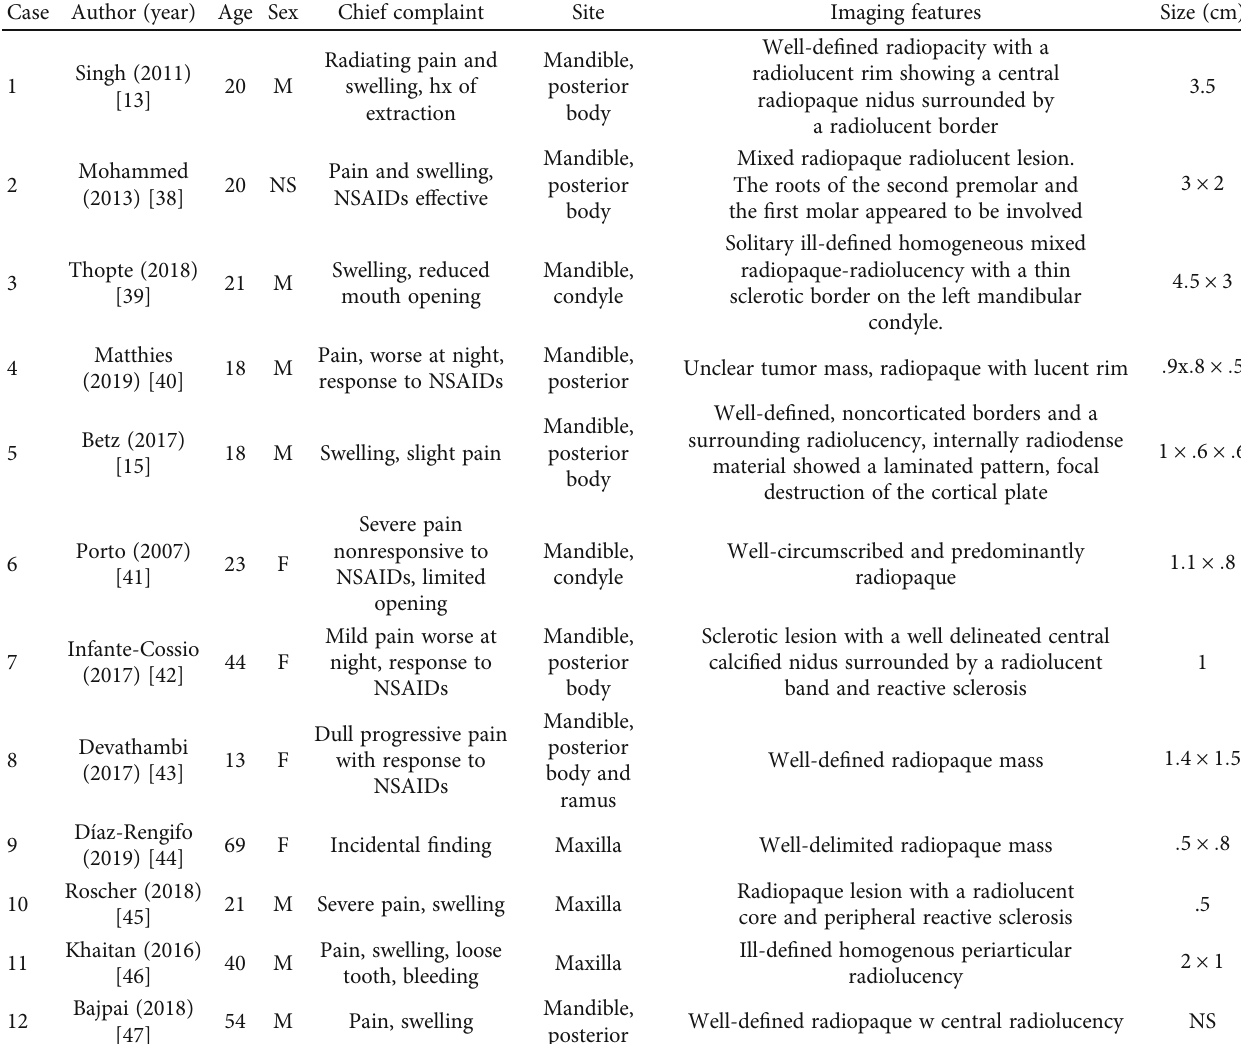
Table 3: Characteristics of previously reported osteoid osteoma of the maxilla and mandible (n =12). Case Author (year) Age